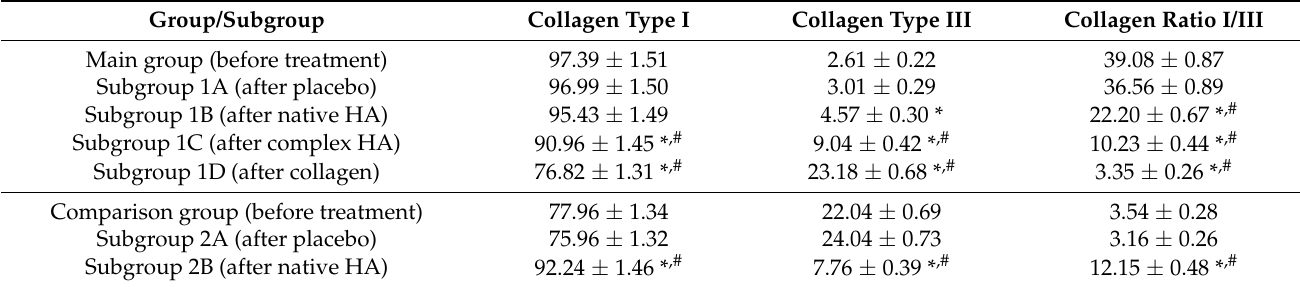
Table 7. The results of polarization microscopy (M ± m,